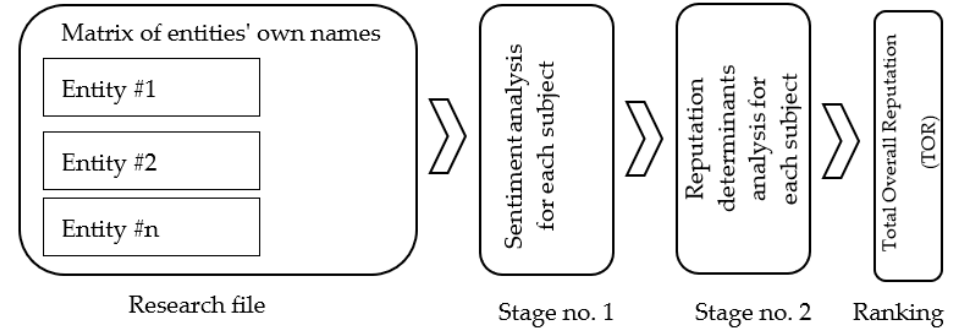
Figure 2. Comprehensive analysis of the level of online reputation.